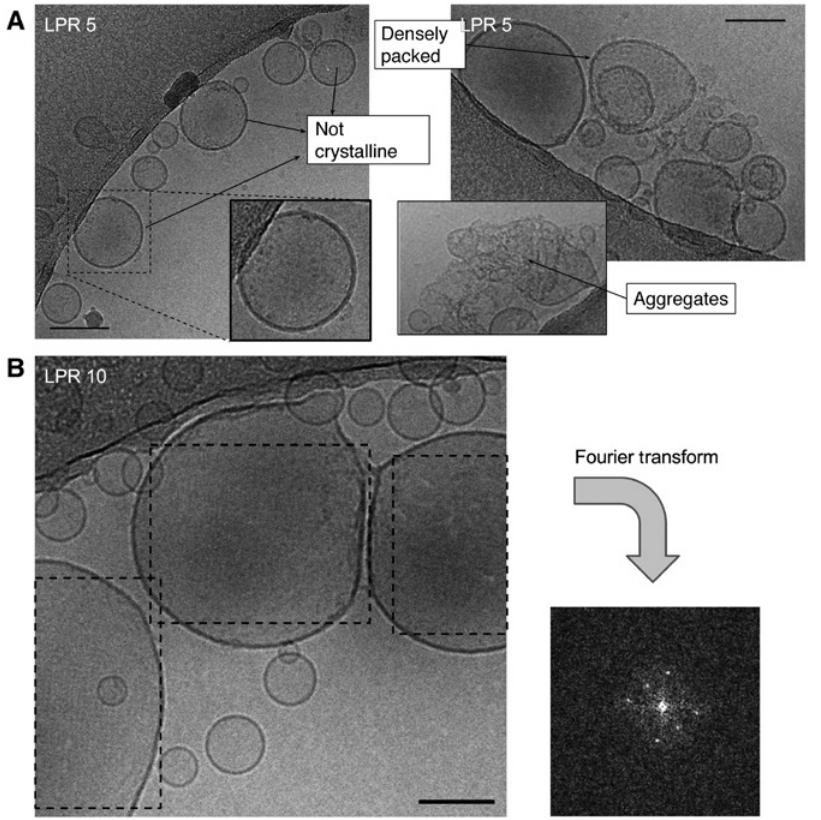
Figure 7: Cryo-EM images of liposomes reconstituted with the potassium channel MloK1. In the crystallization screens, liposomes from E. coli polar lipid extract preformed by the film dispersion method and dispersed in 20 mm Tris-HCl pH 7.6, 20 mm KCl, 1 mm BaCl 1 mm EDTA were mixed with detergent-solubilized MloK1 in 295 mm NaCl, 5 mm KCl, 20 mm Tris-HCl pH 8.0, 10% glycerol, 1 mm phenyl- methylsulphonyl fluoride, 40/500 mm (wash/elution) imidazole, 0.2% n-decyl- β -D-maltopyranoside at LPRs ranging from 1 to 10, added to dialysis buttons sealed by a dialysis membrane with a 14-kDa molecular weight cut-off, and dialyzed for 48 h at room temperature to remove detergent. (A) Optimization of MloK1 reconstitution in liposomes by changing the LPR; although some liposomes are densely packed with MloK1, regular 2D crystalline arrays are not present. (B) Vesicular patches of MloK1 formed at an LPR of 10 and the aligned and averaged Fourier transform of the patches, indicating some weakly crystalline arrangement. Only diffraction spots up to orders (1,1) are visible above the noise. Their spacing does not agree with the crystalline arrangement obtained from planar well-ordered 2D crystals of MloK1 [98, 99], indicating that the crystal packing is different. MloK1 had an up/down alternating orientation in the latter. It might be unidirectional in the vesicular crystals as expected from the preparation method, but this remains to be shown. Scale bars: 100